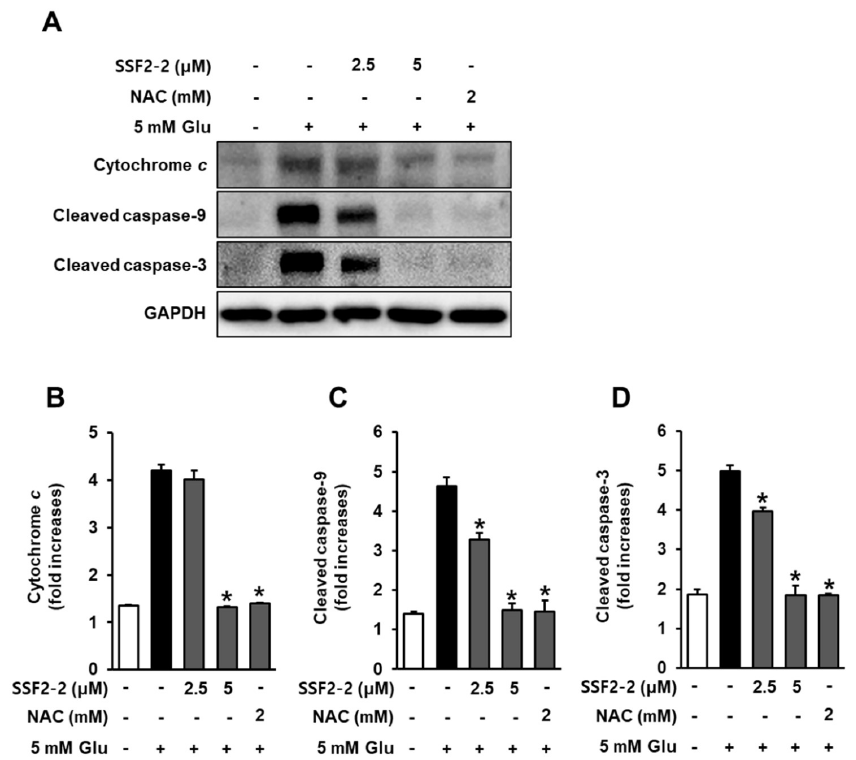
Figure 9. Effects of SSF2-2 on glutamate-induced cytochrome c release and cleaved caspase-9, -3. HT22 cells were incubated for 24 h with 5 mM glutamate (Glu) with or without compound SSF2-2 at 2.5 and 5 µ M, and then subjected to western blot. ( A ) Protein expression of cytochrome c , cleaved caspase-9, cleaved caspase-3, and GAPDH. Fold increases in protein expression of ( B ) cytochrome c , ( C ) cleaved caspase-9, and ( D ) cleaved caspase-3. Data represent the mean ± S.E.M., n = 3, * p < 0.05 compared with the glutamate-treated group.